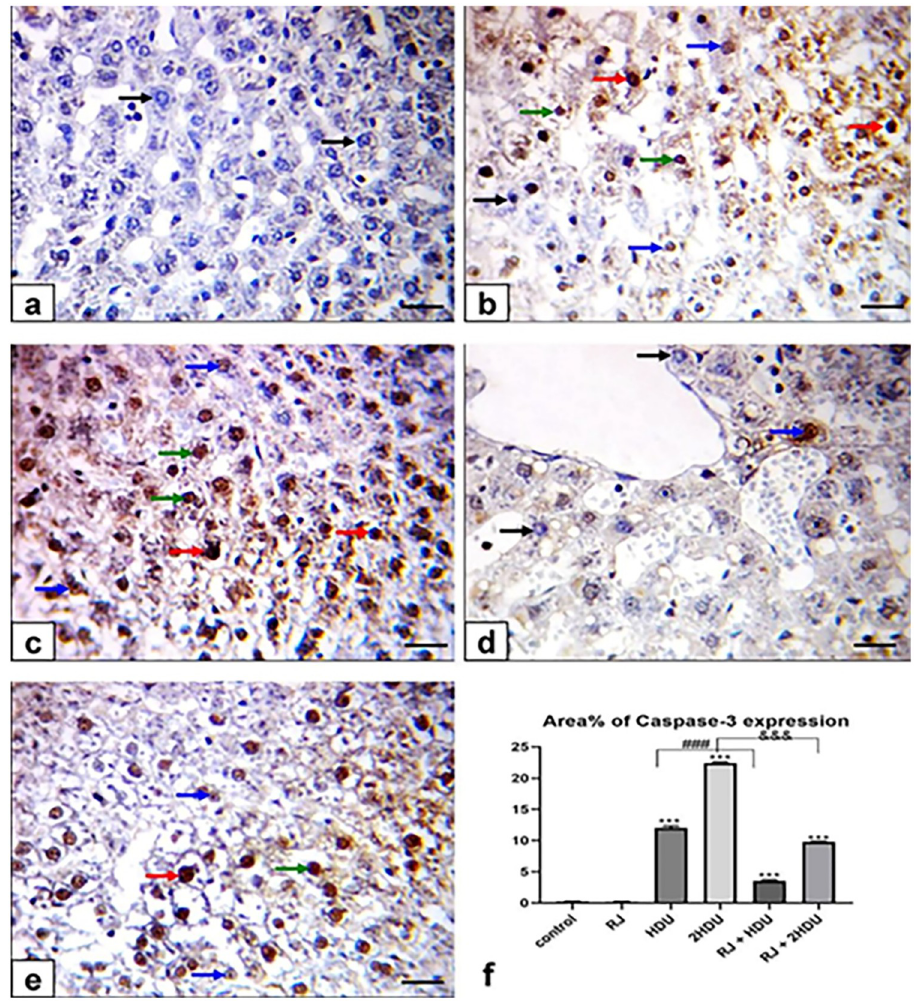
Fig 6. Effects of oral royal jelly (RJ; 100 mg/kg bwt) administration on hepatic caspase-3 protein expression in rats treated with hydroxyurea (HDU; 225 or 450 mg/kg bwt) 60 days. Photomicrograph of Immunohistochemical staining of the hepatic caspase-3 protein expression (scale bar = = 50 μ m). (a) control showing negative immunostaining for Caspase-3 protein, (b) HDU (225 mg/kg bwt), (c) 2HDU (450 mg/kg bwt), (d) RJ + HDU and (e) RJ + 2HDU showing nuclear caspase-3 expression in hepatocytes. Negative immunostained hepatocytes (black arrows), strong (red arrows), moderate (green arrows), weak (blue arrows) nuclear caspase-3 expression in hepatocytes. (f) lessening effect RJ on the area (%) of caspase-3 positive cells in the liver of HDU- intoxicated rats. Data are presented as the mean ± SEM. Compared to the control, significance at (p < 0.001) ��� (ANOVA with Dunnett’s multiple comparison test). Compared to HDU treated groups using Unpaired t-test, significance at p < 0.001 ### and &&& for HDU and 2HDU groups,